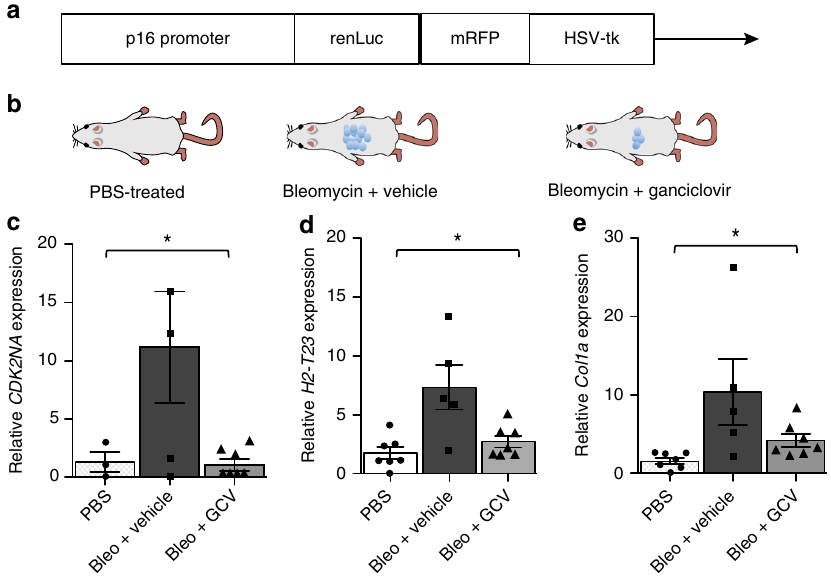
Fig. 5 The expression of Qa-1 b (mouse homolog of HLA-E) in p16-3MR mice. a Schematic of the p16-3MR (trimodality reporter) fusion protein, containing functional domains of a synthetic Renilla luciferase (LUC), monomeric red fl uorescent protein (mRFP) and truncated herpes simplex virus 1 (HSV-1) thymidine kinase (HSV-TK) driven by the p16 promoter. b p16-3MR mice were treated with bleomycin (intra-tracheal injection, 1.9 UI/Kg), ganciclovir (GCV, 25 mg/kg; daily i.p. injections) or PBS; c – e qRT-PCR was used to quantify levels of mRNAs encoding p16 INK4a ( CDKN2A ), Qa-1 ( H2-T23 ) and collagen ( COL1A1 ) in lungs from mice treated with PBS (white bar), bleomycin + vehicle control (black bars) and bleomycin + GCV (grey bars). mRNA levels for the indicated genes were normalised to tubulin and presented as fold difference relative to PBS-treated mice. Statistical analysis between groups performed with one-way ANOVA with Bonferroni's multiple comparison test. The data presented as means ± SEM. * p < 0.05, ** p < 0.01, *** p < 0.001, **** p <